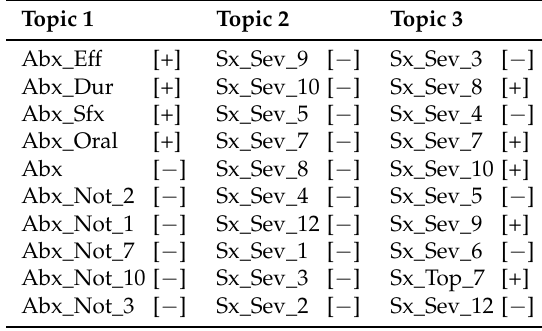
Table 5. Results of SPCA with three topics on MLD. We show the ten topic features with highest magnitude, and whether they contribute positively or negatively to the